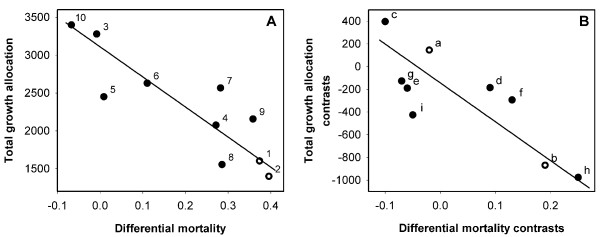
Allocation to growth versus differential extrinsic mortality for the eight parasitic castrator trematode species (operating stolen host bodies) and both genders of uninfected horn snails. (A) The analysis using species as independent data points (r = -0.86, P = 0.0014, n = 10). (B) The analysis using phylogenetically independent comparisons (r = -0.81, P = 0.0060, n = 9; regression through the origin: t8 = 4.0, P = 0.004). Total growth allocation is the area underneath the species' growth curves in Figure 1, calculated as the definite integral with limits at the minimum- and maximum-sized snail averaged across species. Differential mortality is the mean proportion of individuals killed by dominant trematodes, or, for uninfected snails, reproductively killed by trematodes. Symbol numbers indicate species as numbered in Figure 1 and Additional file 1, Table S1. Symbol letters indicate locations of contrasts in the phylogeny depicted in Figure 4. Open symbols represent uninfected snails or contrasts involving uninfected snails. Fit lines are the standard major axes, reflecting the bivariate nature of the data.